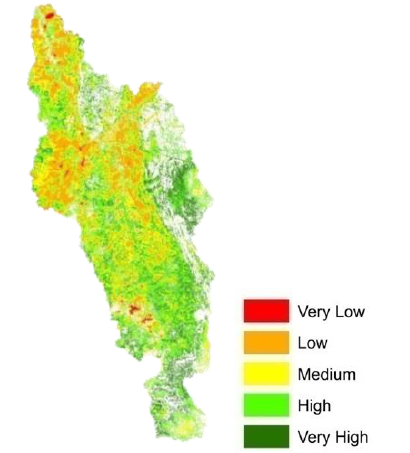
Figure 2. Suitability map for the reforestation of the VRW The class with the greatest representativity was the High Suitability Class, with 6,983.4 km² (37%), followed by the Medium Suitability Class, with 4,956.3 km² (26%) and the Low Suitability Class, with 4,398.2 km² (23%). The least representative classes are those of the extremes, the Very